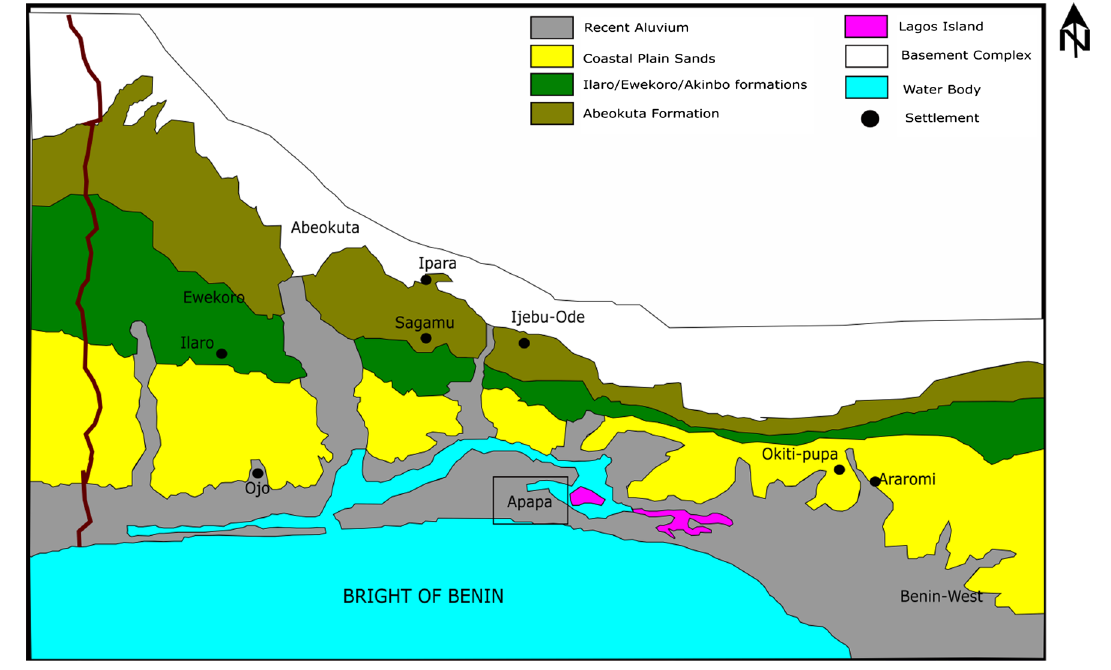
Fig. 1 Geological map Dahomey Basin showing the location of the study area (insert). Modified after Whiteman